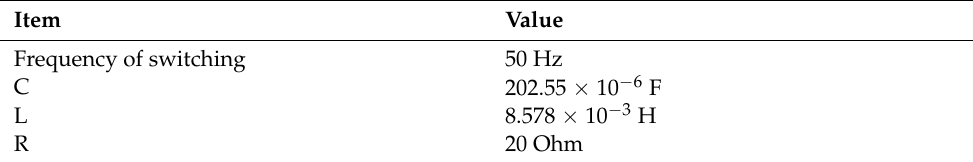
Table 2. DC/DC boost converter parameters.